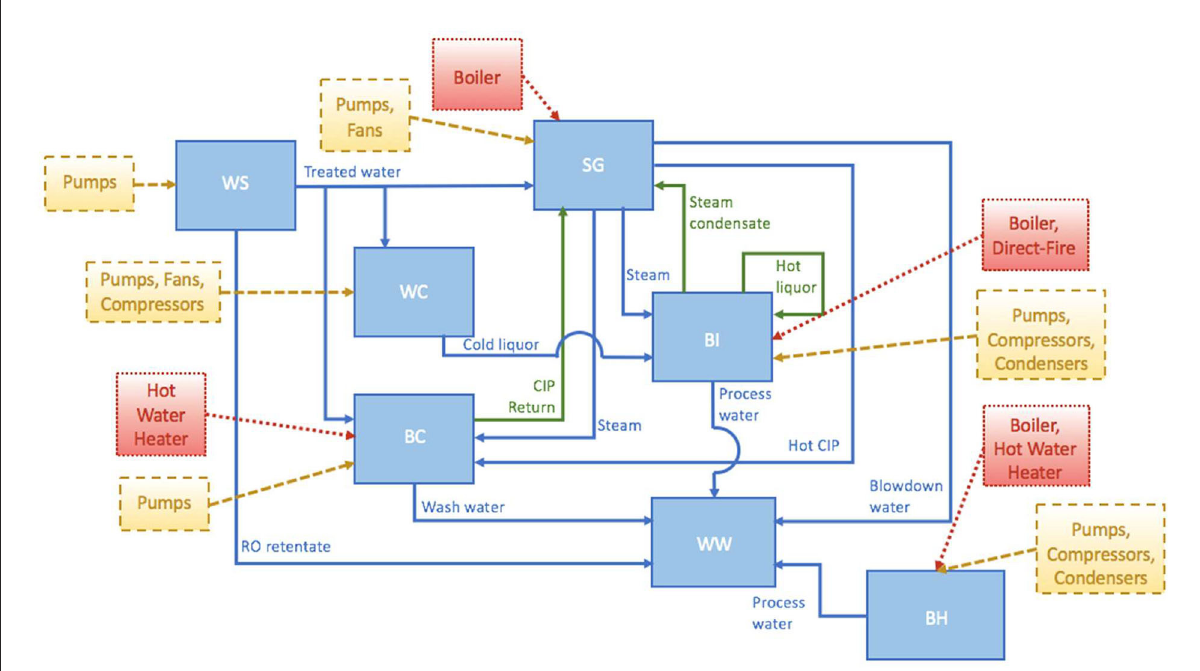
FIGURE1 Schematic representation of the water energy nexus (WEN) at the brewery [Figure shows how water flows between WEN points (blue) and where it is reused (green). Blue boxes represent WEN points at which major process tasks are accomplished and at which energy may be embedded in water. WEN points are labeled using abbreviations (see Table 1). The streams between WEN points are labeled. The energy that is embedded in the water at the WEN points is shown in yellow (electrical) and red (thermal), labeled with the types of equipment imparting the energy. Not shown are areas where water leaves the network of WEN points, for example, as product, lost steam, filtration losses, fermentation losses, and absorbed by spent grains].